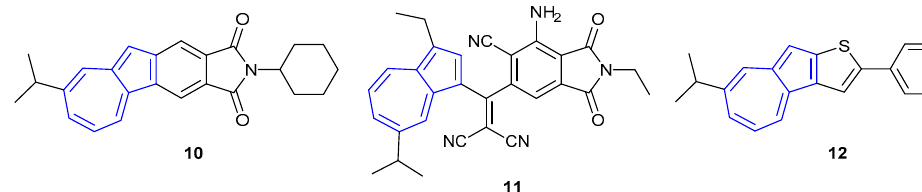
Figure 9. Fused and unfused azulene systems synthesised by Shoji et al. [55–57] . The most recent entry in the literature on protonation-dependent fluorescence of azulene was reported by Lewis, Kann and co-workers in 2020 [29]. They found that 1,3-difunctionalised azulenes 13a – e (Figure 10) protonated upon the addition of TFA, for which a strong turn-on fluorescence response was reported in each instance. Of all the compounds assayed, azulene 13c was found to undergo the greatest fluorescence enhancement when protonated ( λ ex = 266 nm, λ em = 336 nm), for which the tricarbonyliron(diene) moiety did not lead to emission quenching.